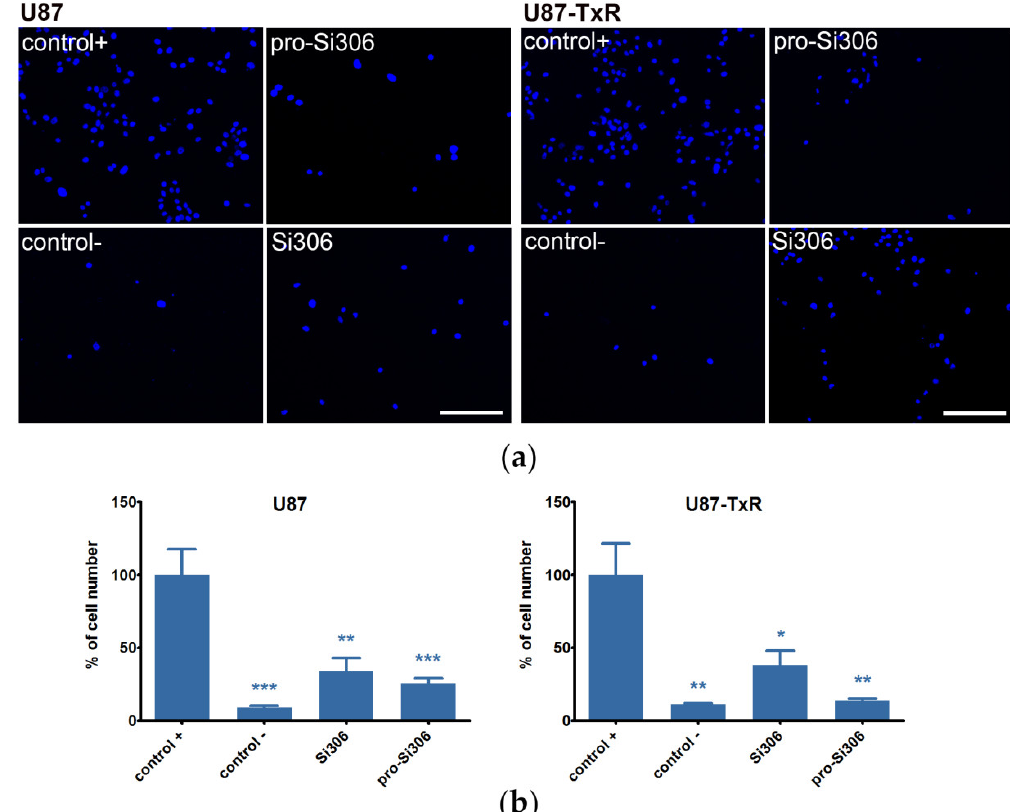
Figure 4. Si306 and pro-Si306 suppress GBM cell lines invasion through the basement membrane. ( a ) Representative images of U87 and U87-TxR cells that invaded through matrigel to the opposite side of the membrane after 24 h treatment with 5 µ M Si306 and pro-Si306. Scale bar = 200 µ m. ( b ) Percentage of U87 and U87-TxR cells that invaded through matrigel and passed the membrane. Values are expressed as mean ± SEM ( n = 3). C + is positive control (with fetal bovine serum (FBS) as chemo-attractant) and C- is negative control (without chemo-attractant). Statistical significance compared to positive control group is shown as * ( p < 0.05), ** ( p < 0.01), and *** ( p < 0.001).